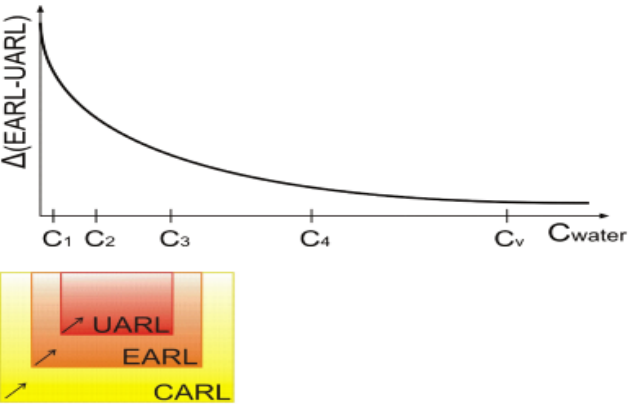
Figure 4. Moving from Economic Annual Real Losses (EARL) to Unavoidable Annual Real Losses (UARL) (in terms of necessary investment cost)